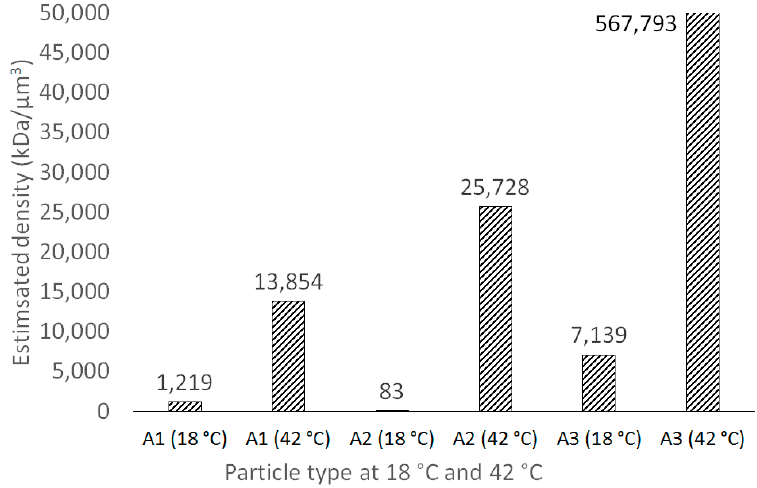
Figure 6. The variability of estimated density of thermosensitive particles A1–A3 at 18 and 42 °C. The highest density increase was observed for A2 (3.13 ∙ × 10 4 %), whereas for A1 and A2, the increases were lower (1.13 ∙ × 10 3 % and 7.96 ∙ ×10 3 %, respectively).